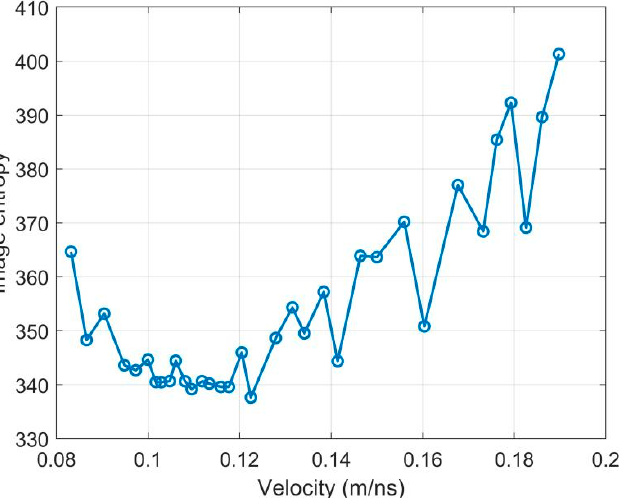
Figure 6. The migration velocity analysis results using image entropy. The minimum corresponds to 0.1225 m/ns.